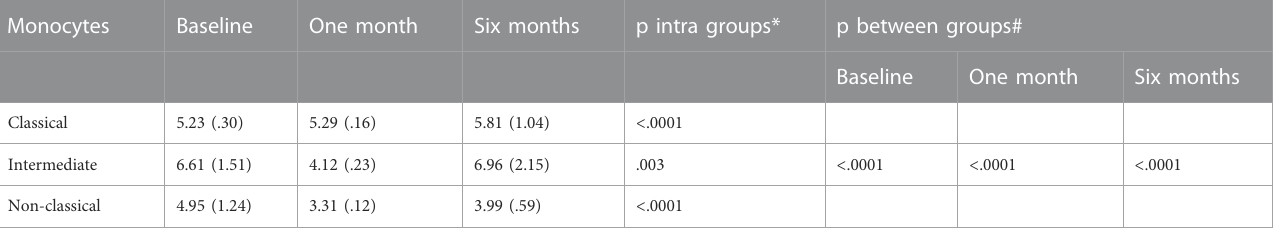
TABLE 5 Level of expression (a.u.) of the receptor CCR5 in monocyte subtypes, throughout the